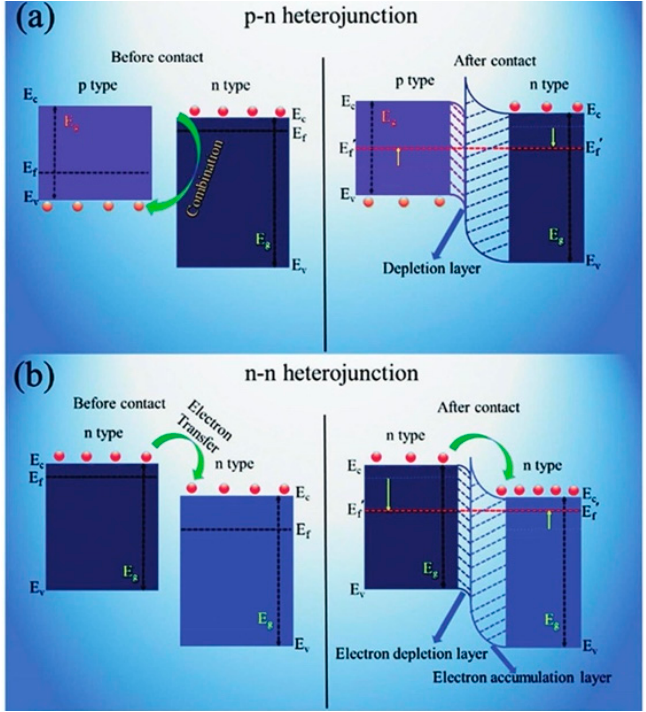
Figure 14. Schematic illustrations of the energy band structures at heterojunction interfaces of ( a ) p–n and ( b ) n–n of heterojunctions [178]. 2019 The Royal Society of Chemistry.